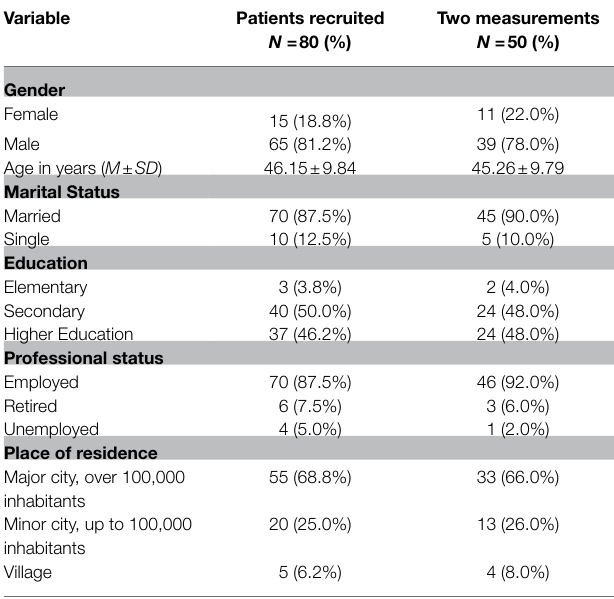
TABLE 1 | Socio-demographic characteristics of the group of patients recruited for the study ( N = 80) and the group of patients participating in two measurements ( N =